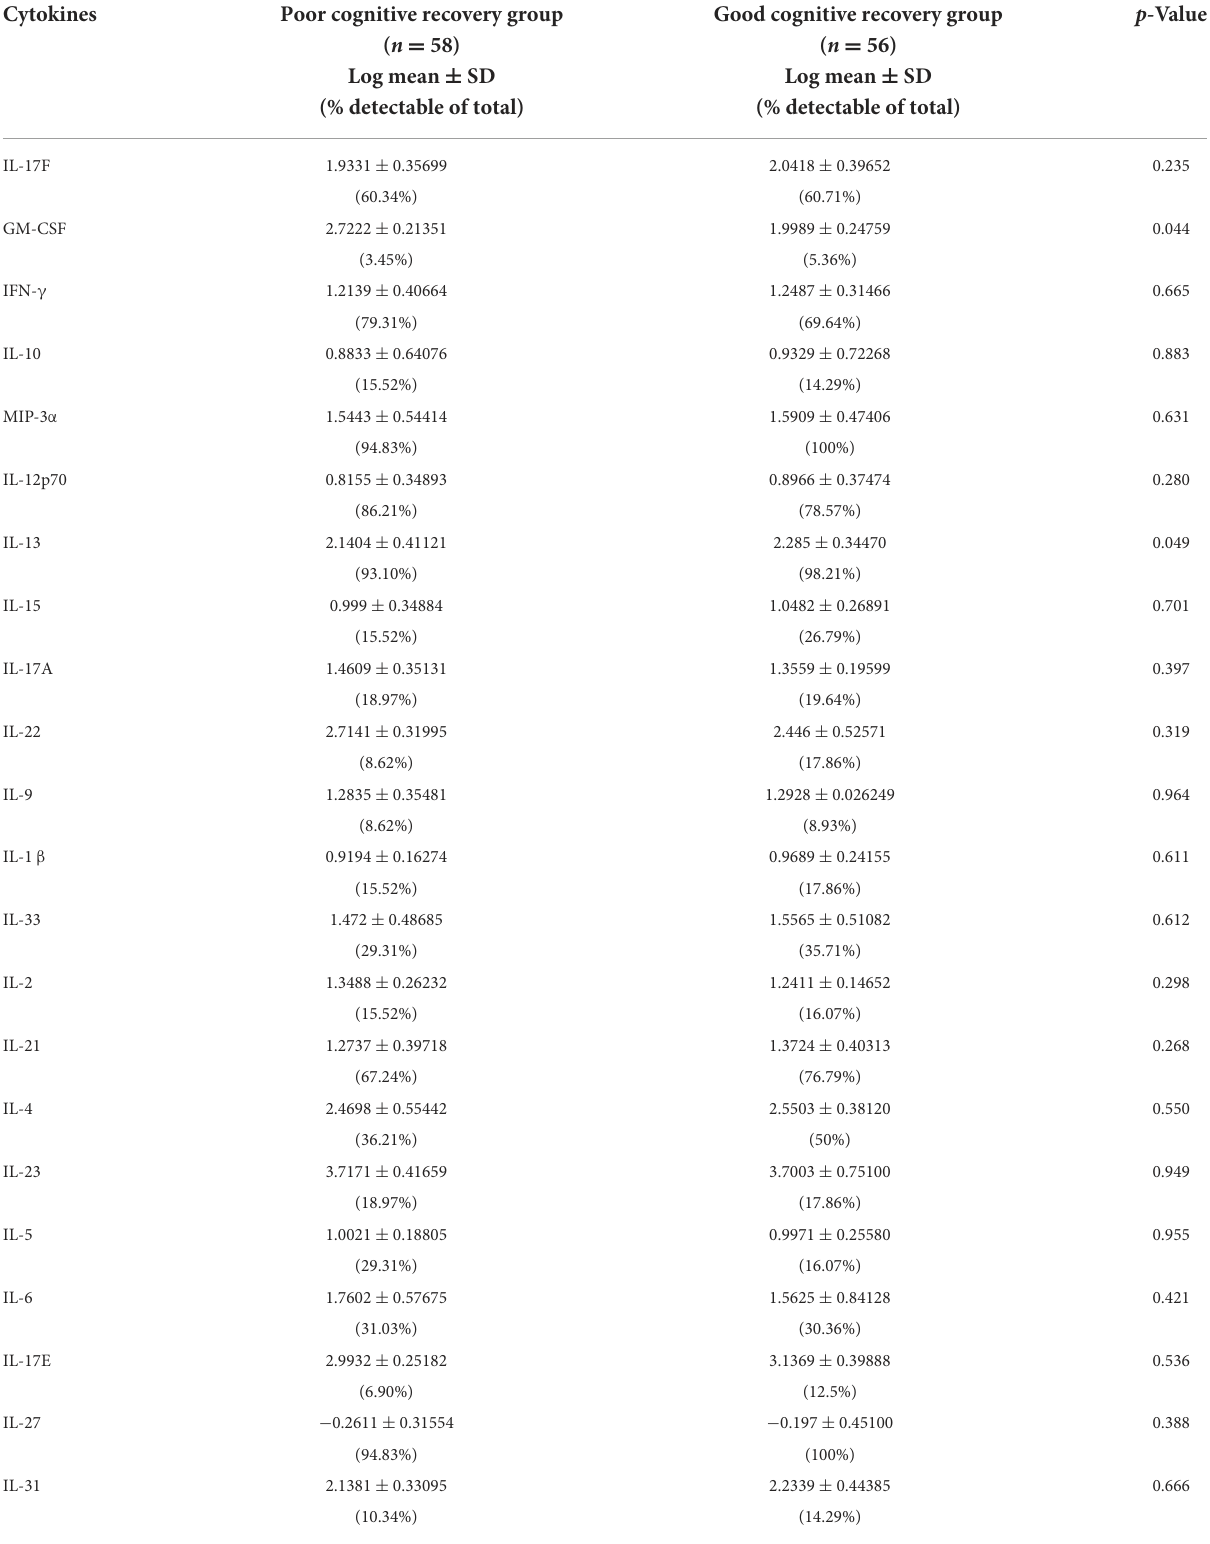
TABLE 2 The serum cytokines detection in two